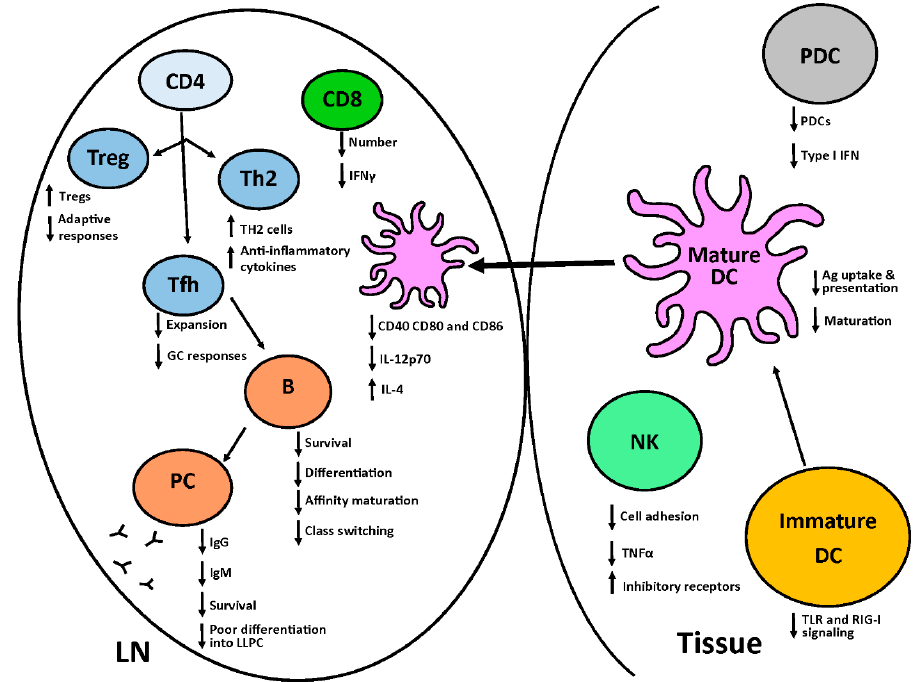
Figure 1. The neonate immune system has alterations that span both the innate and adaptive arms, both of which are important in viral clearance. Within the innate arm, NK cells have functional deficiencies that include decreased cell adhesion due to a reduction in selectins, reduced TNF α production, and increased inhibitory receptors. The number of neonatal PDCs is reduced as well as the amount of type I IFN produced from these cells. Potent adaptive immune responses are dependent on the capacity of DCs to undergo maturation together with the robust activation, di ff erentiation and survival of T and B cells. DCs from newborns are challenged in this process, as they have decreased capacity to respond to PAMPs through TLR and RIG-I receptors resulting in impaired costimulatory molecules (CD40, CD80 and CD86) expression as well as diminished IL-12p70 production that is essential for the di ff erentiation of CD4 TH1 cells and CD8 + T cells. There is also increased IL-4 production from newborn DCs. The low levels of IL-12p70 accompanied by increased IL-4 production skews the di ff erentiation of CD4 + T cell towards TH2 cells. Decreased IL-12p70 impacts the CD8 + T cell di ff erentiation leading to decreased production of IFN γ . Neonates also have heightened Treg responses. There are functional defects in neonatal Tfh cells including limited expansion leading to poor GC responses and reduced production of high a ffi nity, isotype switched